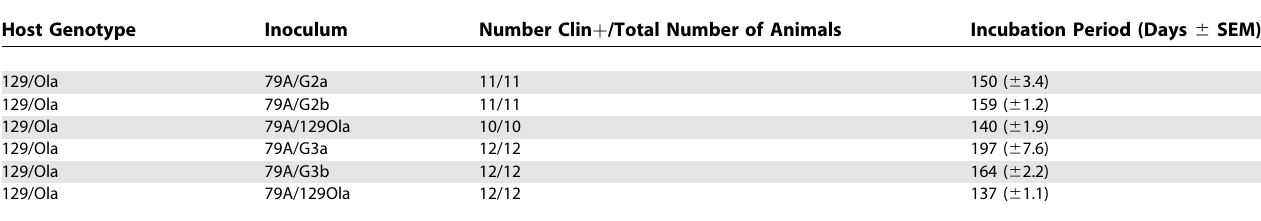
Table 2. Second Passage of G2 and G3 Mouse Brain Inoculated with 79A; Incubation Periods of 129/Ola Mice Host